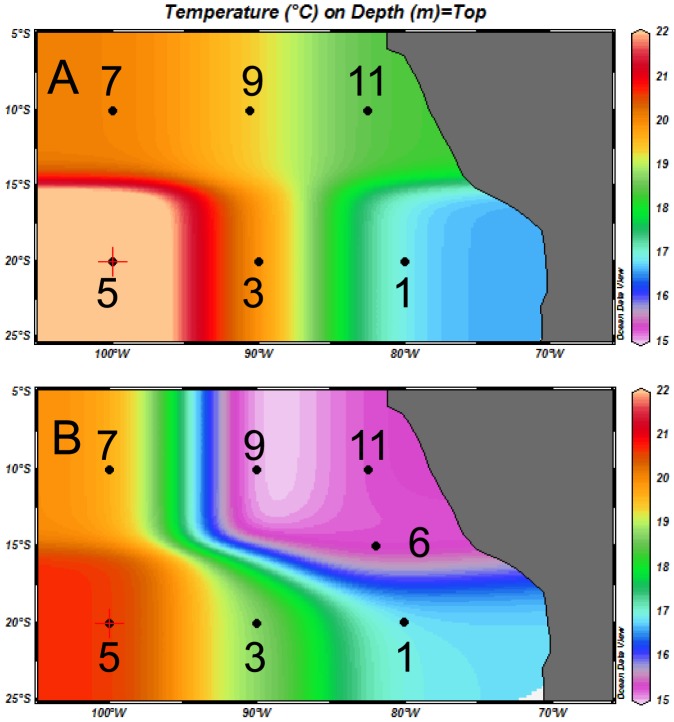
Location of stations superimposed upon seawater temperature at 75-m-depth.(A) the 2010 cruise (R/V Atlantis), and (B) the 2011 cruise (R/V Melville). Station numbering are identical to that of 2 companion papers [28], [42]).